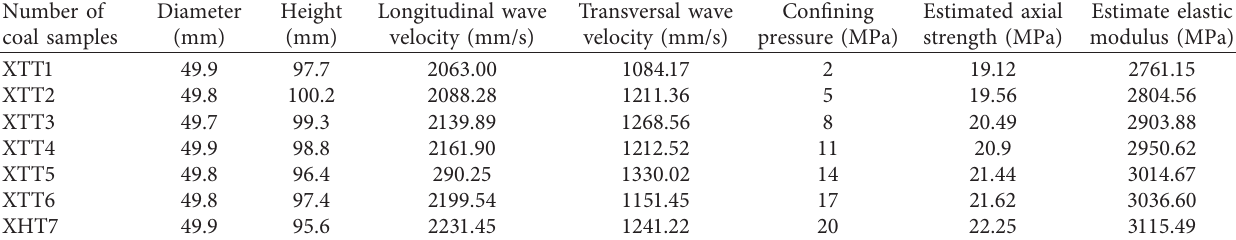
Table 1: Basic parameters of coal samples.